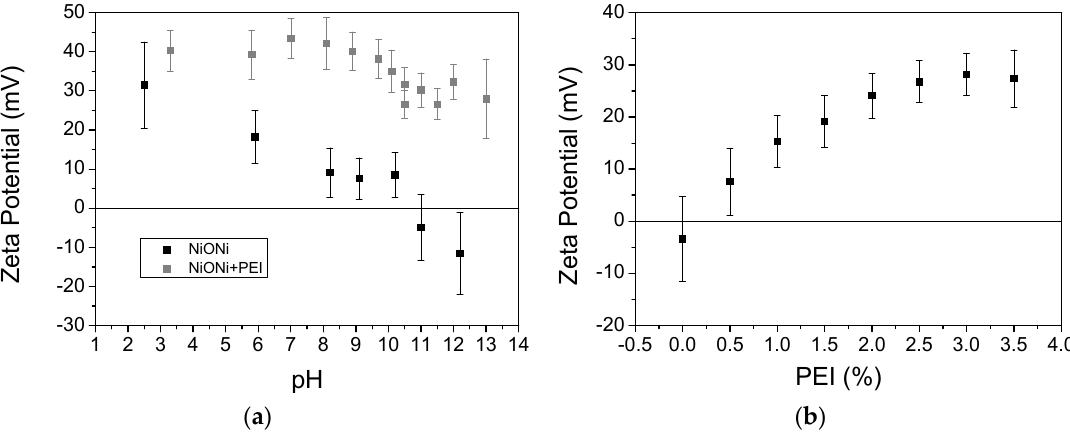
Figure 3. ( a ) Zeta potential vs pH curves for NiO ‐ Ni nude nanoparticles and the stabilized with PEI; and ( b ) Zeta Potential of NiO ‐ Ni nanoparticles as a function of the amount of added polyelectrolyte.